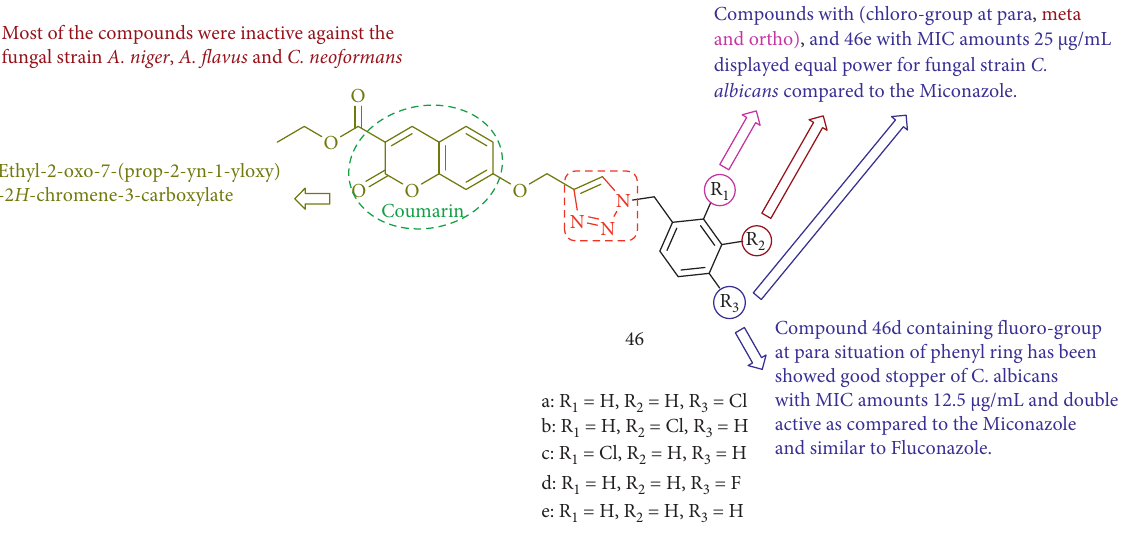
Figure 7: Chemical structure of 1,2,3-triazole incorporated coumarin derivatives.